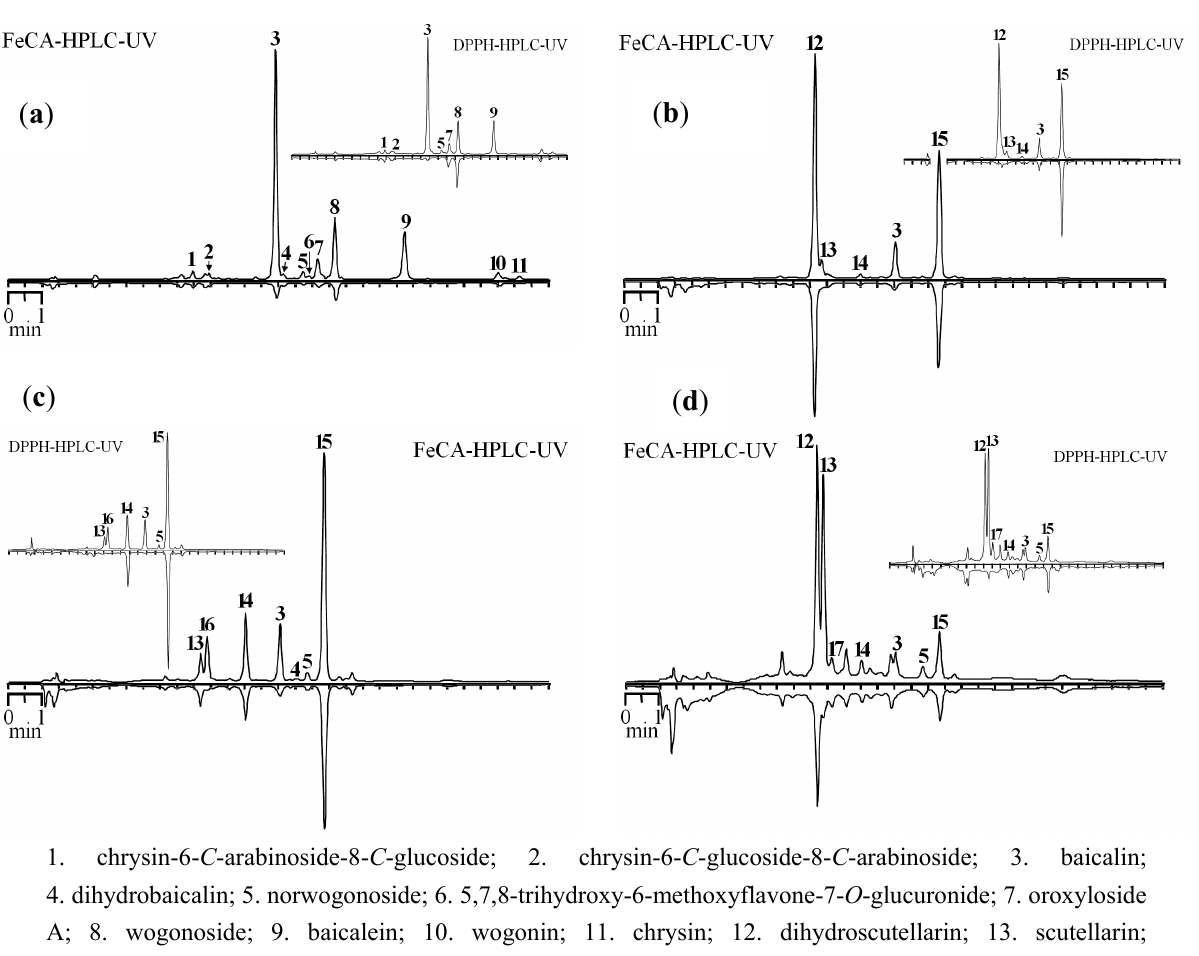
Figure 4. HPLC chromatograms of S. baicalensis extracts before (top chromatogram) and after prechromatographic reaction with Fe 2+ ions (bottom chromatogram) (FeCA-HPLC-UV). Extracts: ( a ) main roots; ( b ) mature leaves of main stem; ( c ) flowers, mass flowering period; ( d ) main stem. On cuts—HPLC chromatograms of the same extracts before (top chromatogram) and after prechromatographic reaction with DPPH • radicals (bottom chromatogram)